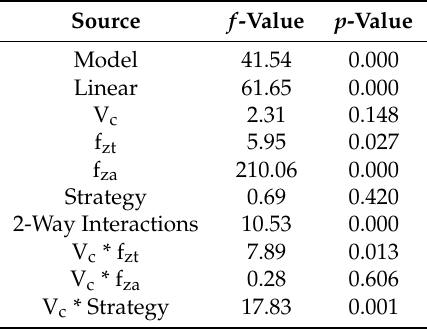
Table 11. Variance analysis for diameter.